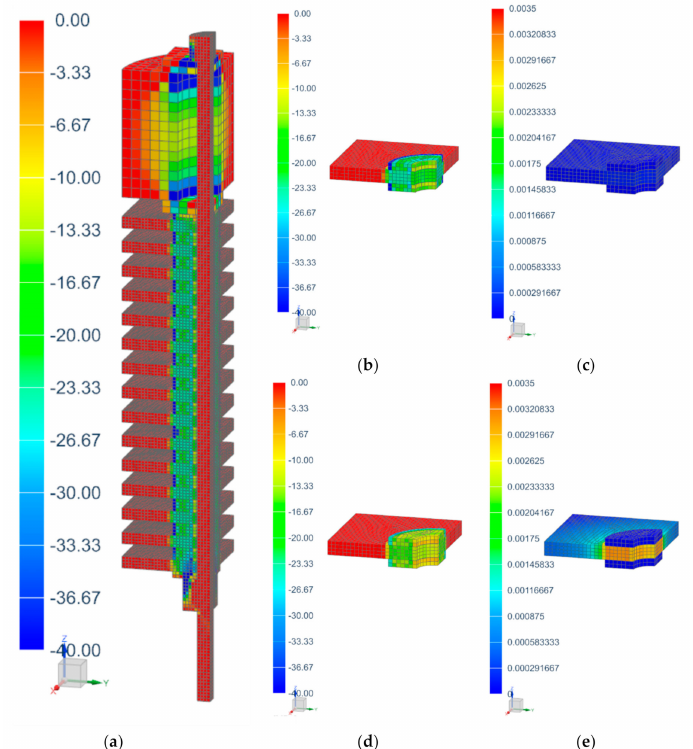
Figure 8. Simulation of screw assembly A in SIEMENS NX Simcenter 12 at 0.01 s (highest bolt pretension) and 300,000 s simulation time. ( a ) Stress in z direction at 0.01 s (MPa); ( b ) Stress in z direction at 0.01 s (MPa); ( c ) Creep strain at 0.01 s (no dim.); ( d ) Stress in z direction at 300,000 s (MPa); ( e ) Creep strain at 300,000 s (no